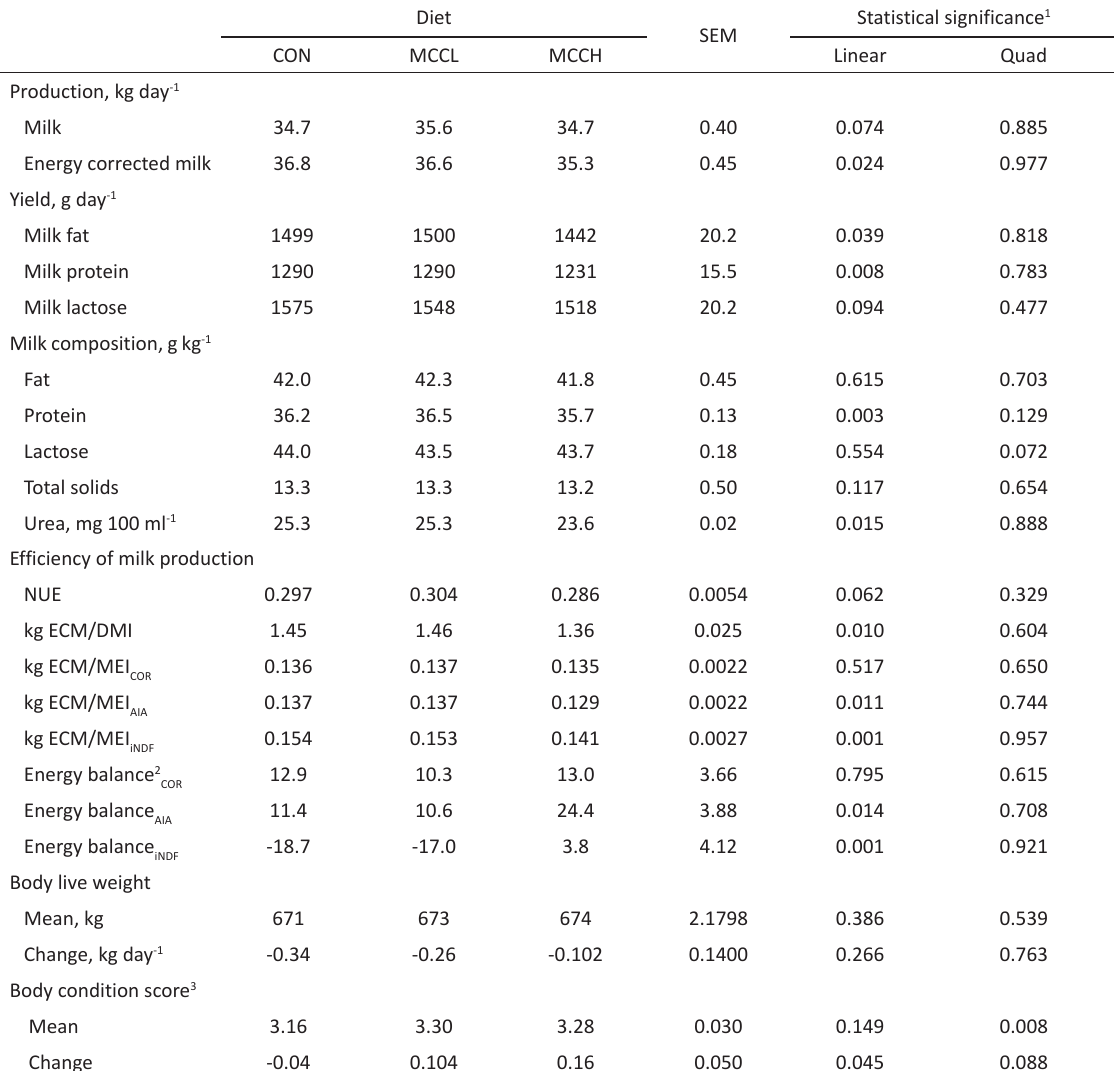
Table 7. Milk production, efficiency of milk production, body live weight and body condition score of dairy cows fed microcrystalline cellulose (MCC) Diet